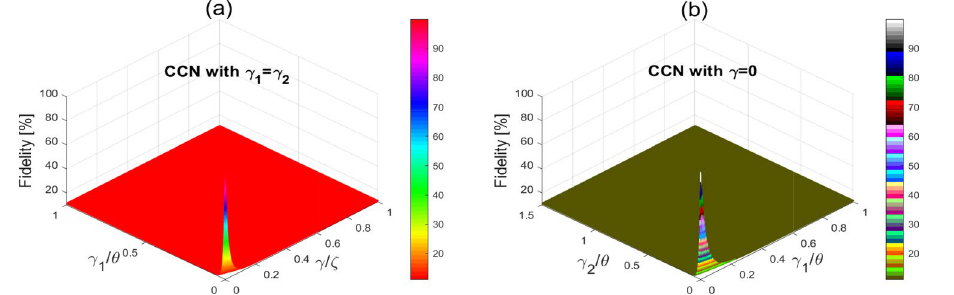
π 4 θ . ( d ) Interacting and non-interacting atoms =